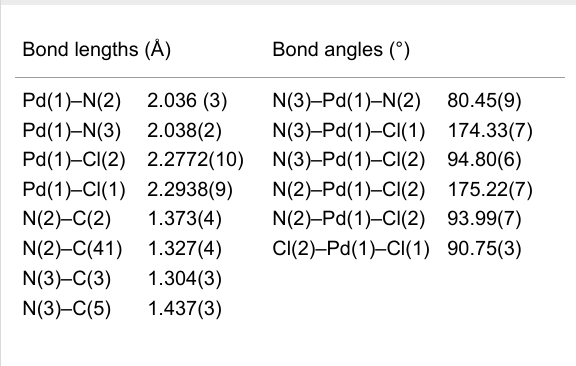
Table 2: Selected bond lengths [Å] and angles [°] for complexes Pd2